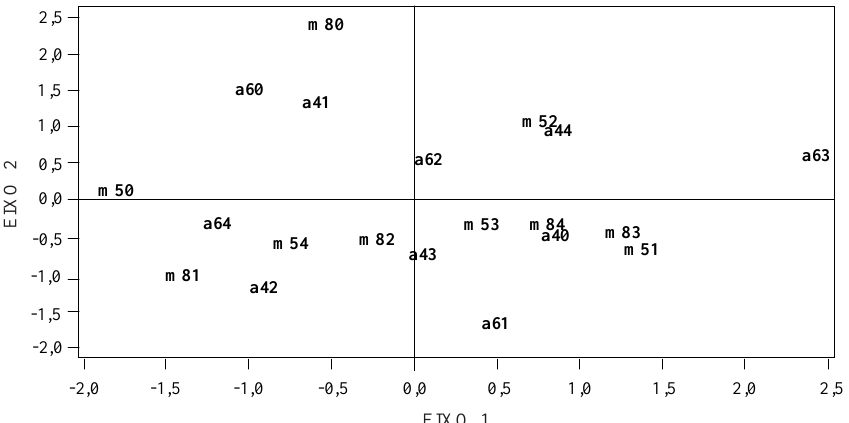
Figura 7. Produtividade por classes - Produtividade de arroz 94 (A40-A44) / Produtividade de milho 95 (M50-M54) / Produtividade de algodão 96 (A60-A64) / Produtividade de milho 98 (M80-M84).